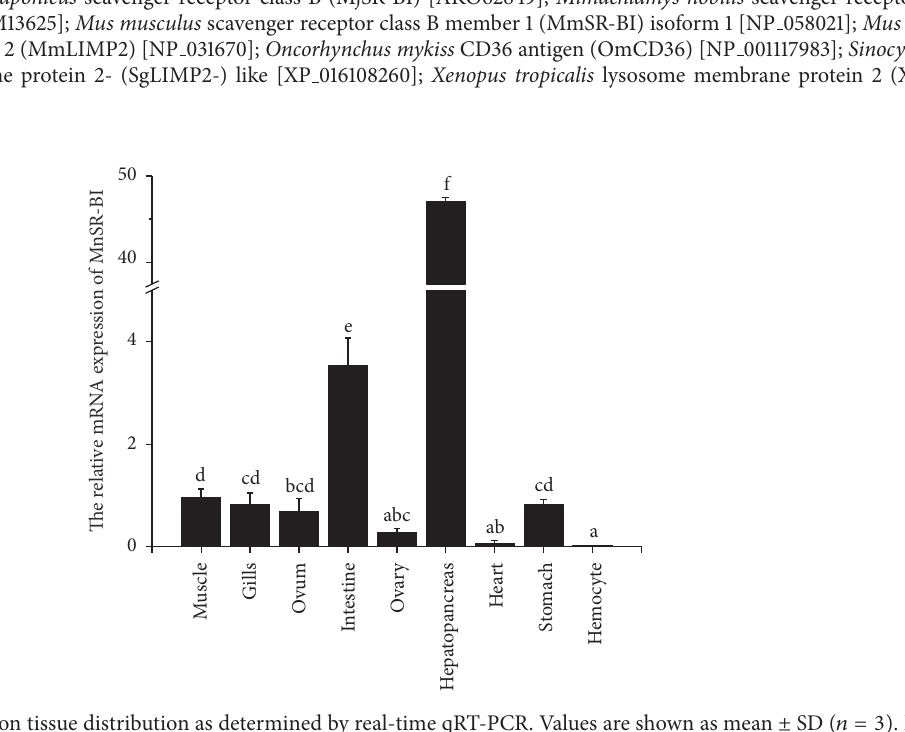
Figure 4: MnSR-BI expression tissue distribution as determined by real-time qRT-PCR. Values are shown as mean ± SD ( 𝑛 = 3 ). Bars with different letters represent significant differences ( 𝑃 < 0.05